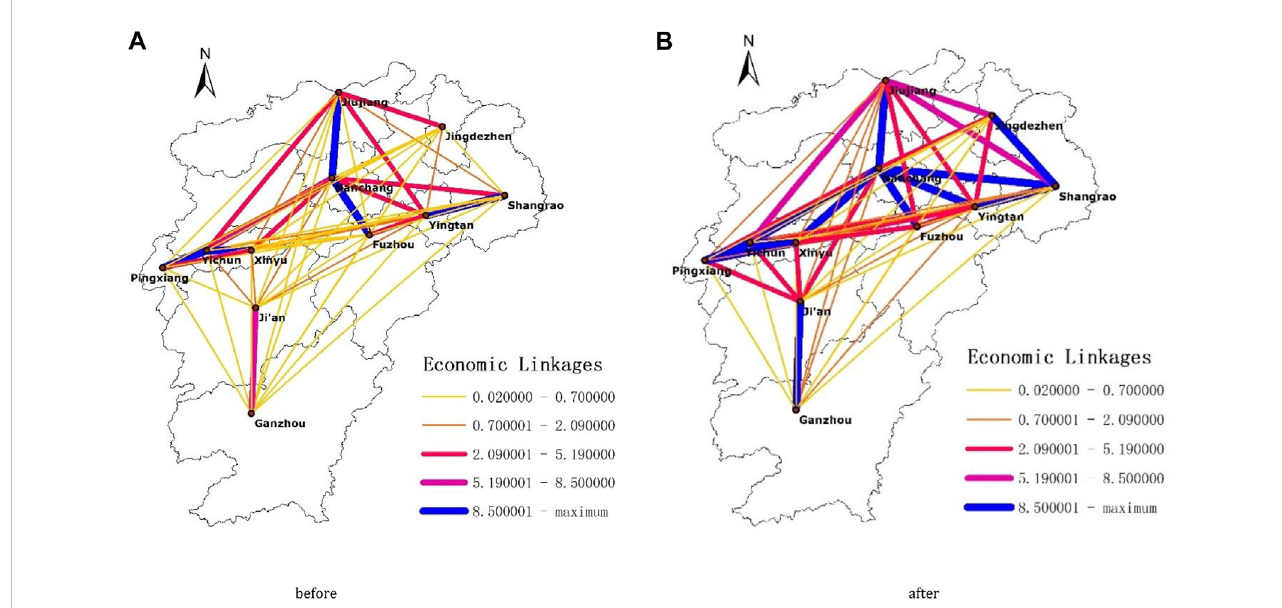
FIGURE 1 Economic linkages change before (A) and after (B) opening high-speed